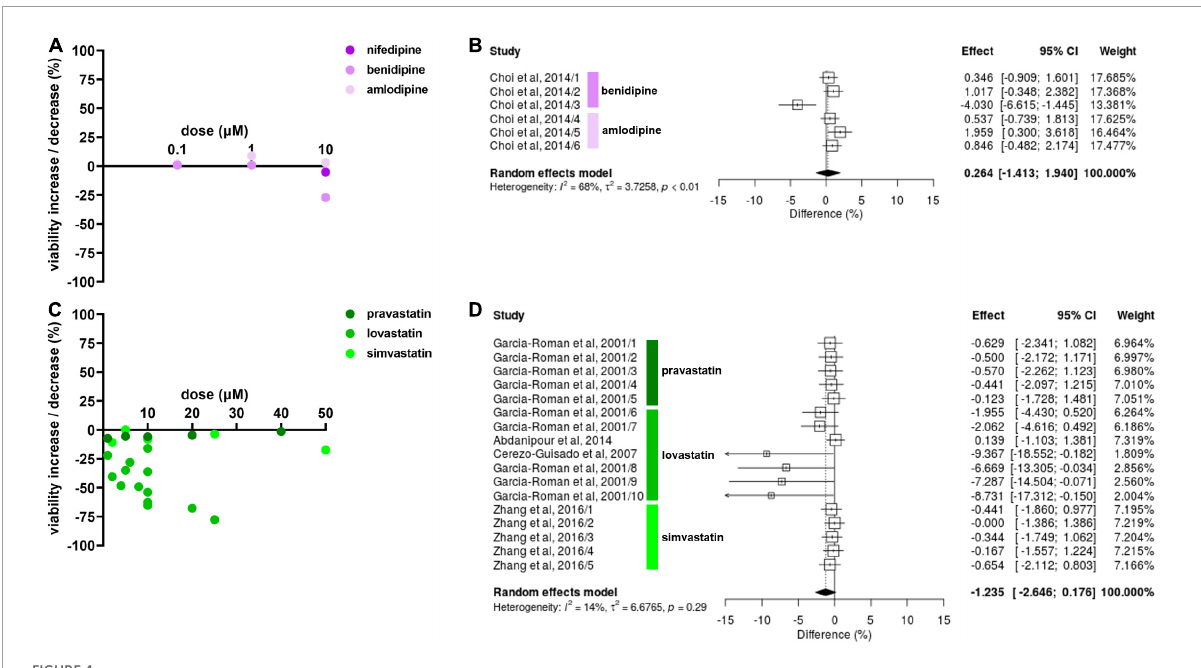
FIGURE4 Drug effects on neural stem cell (NSC) viability. (A) The effect of calcium channel blockers (CCBs) amlodipine and benidipine on NSC viability after 24 h of exposure. (B) Forest plot showing the effect sizes of experiments on amlodipine (0.1, 1, and 10 µ M) and benidipine (0.1, 1, and 10 µ M). There were no statistically significant effects of antihypertensives on NSC viability ( p = 0.76). (C) Effects of simvastatin and pravastatin on NSC viability after 24–48 h exposure. (D) Forest plot showing the effect sizes of experiments reporting the effect of lovastatin (1, 5, 6, 10, 20, and 40 µ M), simvastatin (2, 5, 10, 25, and 50 µ M), and pravastatin (2, 5, 10, 25, and 50 µ M). Although there was a statistically significant effect of lovastatin on reducing NSC viability ( p = 0.02), no statistically significant overall effect on NSC viability was detected ( p =